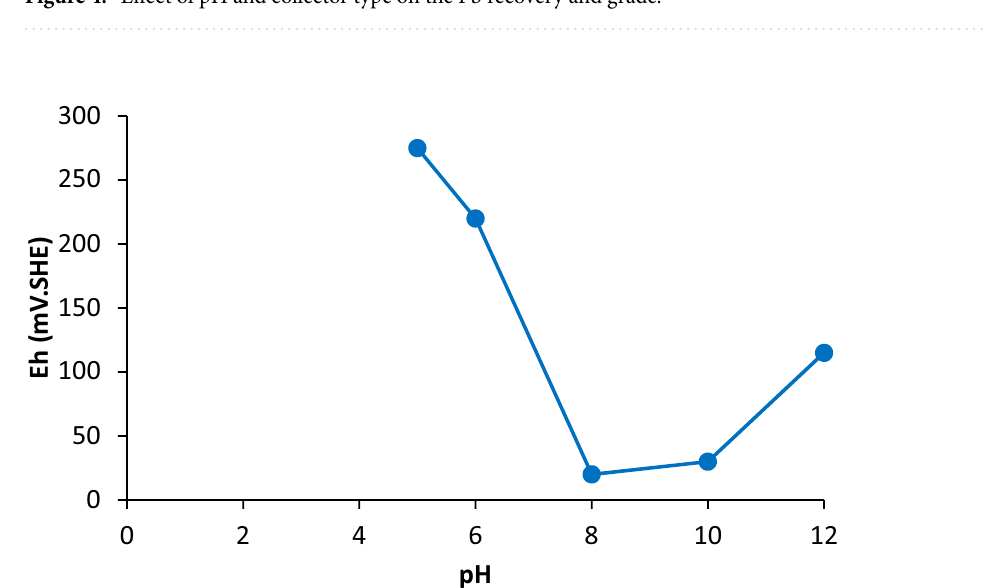
Figure 5. Eh (mV.SHE) vs. pH after pH adjustment and before adding chemicals in the pulp for the lead